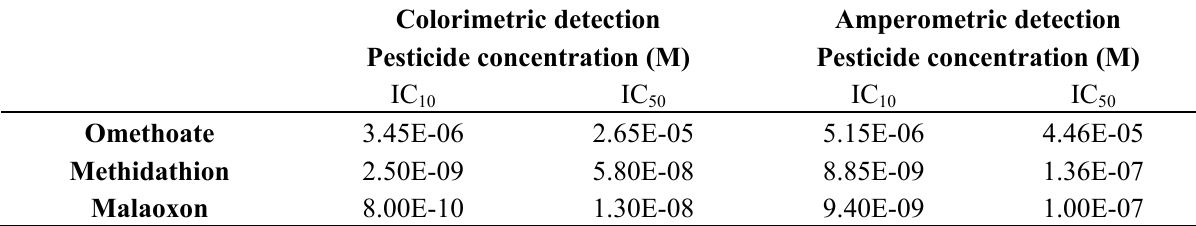
Table 2. The IC and IC values (M) obtained with the two detection methods with the 50 10 three pesticides.